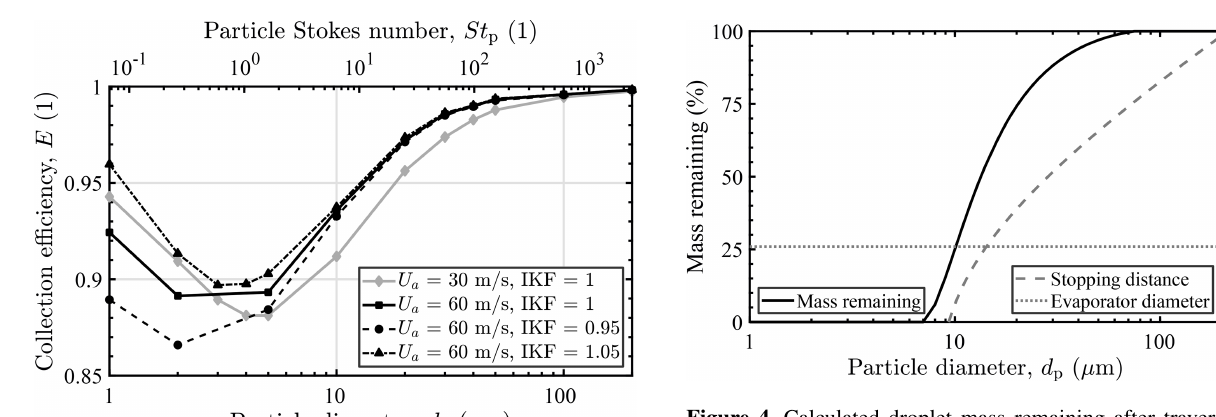
Figure 4. Calculated droplet mass remaining after traversing the probe TW pipe following the evaporator bend and stopping dis- tance as a function of the initial droplet diameter, assuming an am- bient air temperature, pressure, and freestream airspeed of − 5 ◦ C, 1013 . 25hPa, and 60ms − 1 , respectively. The indicated evaporator diameter marks the stopping distance equal to the inlet pipe diame- ter of